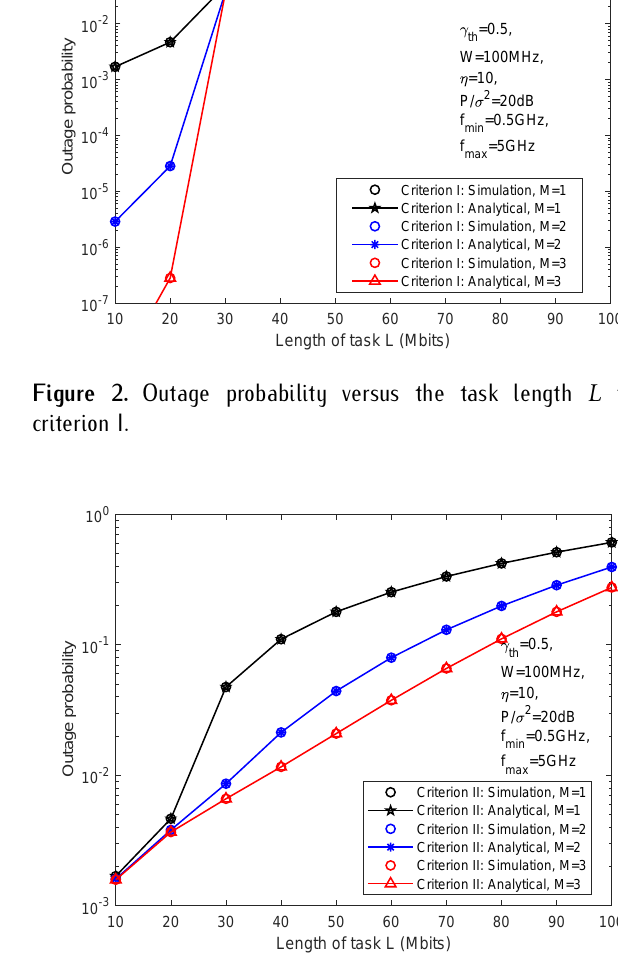
Figure 3. Outage probability versus the task length L for criterion